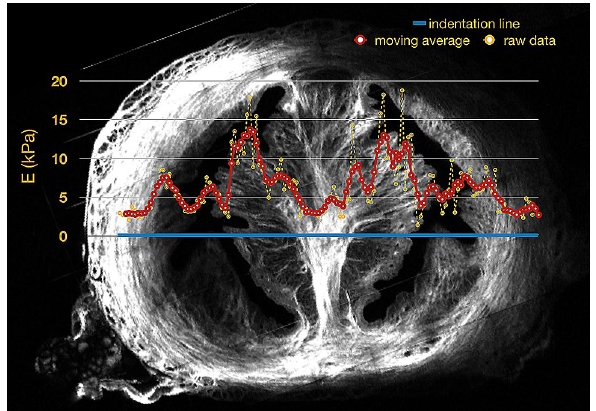
Figure 4. Representative optomechanogram of rat cervix. Raw indentation data (yellow) and the moving average (red, n = 5) of the indentation modulus are aligned with the blue line marking the indentation trajectory.